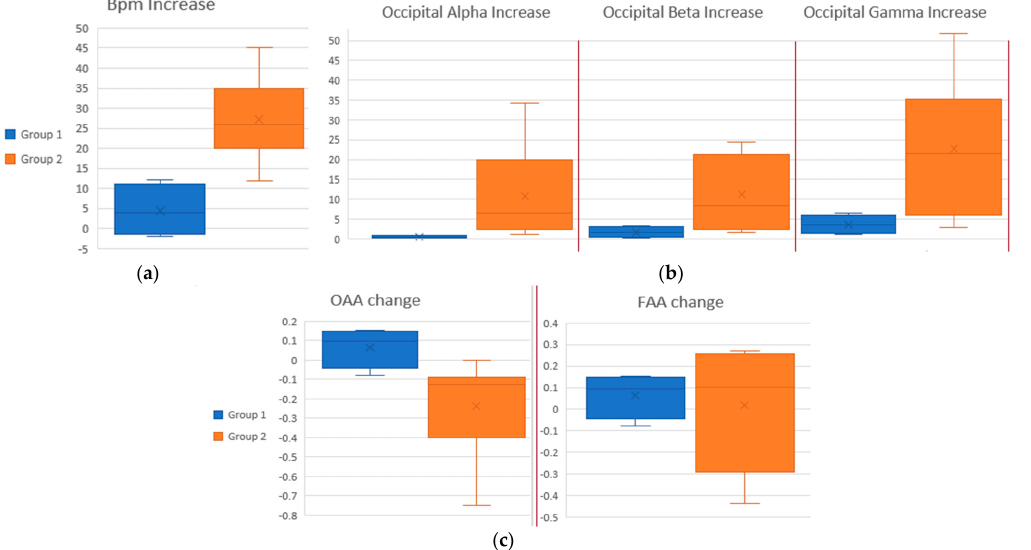
Figure 7. ( a ) Increase in BPM between groups. Y-axis is average BPM in stressed state minus average BPM in calm state. ( b ) Increase in occipital activity compared between groups. Y-axis is Power Spec-